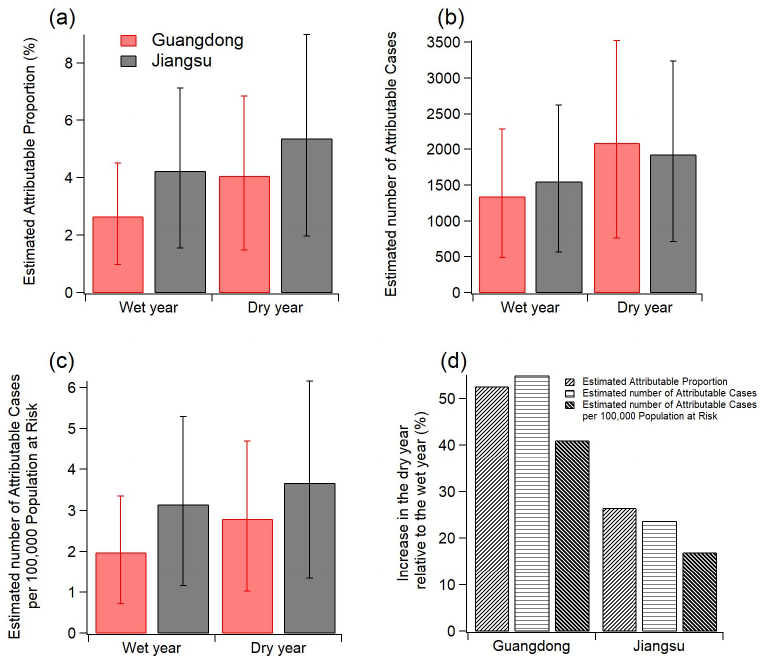
Figure 7. The health outcomes of ozone-related mortality for adults aged 30+: ( a ) attributable proportion due to long-term exposure to O 3 during the wet and dry years in Guangdong and Jiangsu provinces; ( b ) attributable cases due to long-term exposure to O 3 during the wet and dry years in Guangdong and Jiangsu provinces; ( c ) the number of attributable cases per 100,000 population at risk due to long-term exposure to O 3 during the wet and dry years in Guangdong and Jiangsu provinces; ( d ) the relative increase of the three indicators between the wet and the dry years in Guangdong and Jiangsu provinces.